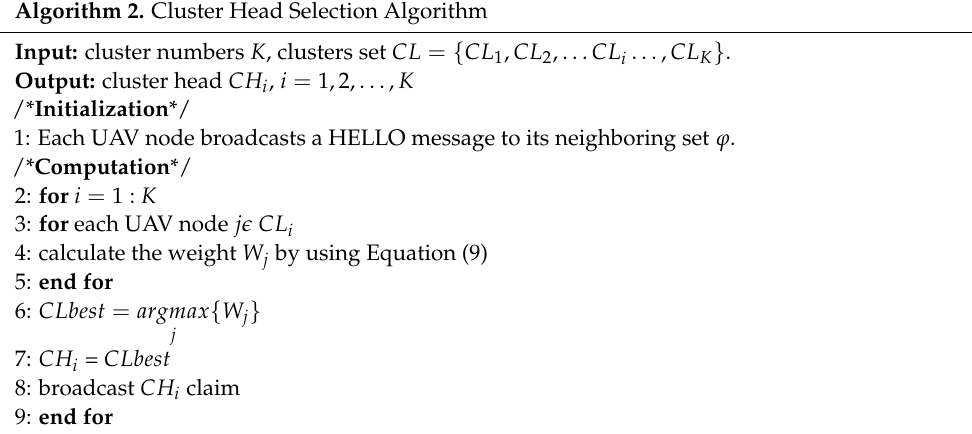
Algorithm 2. Cluster Head Selection